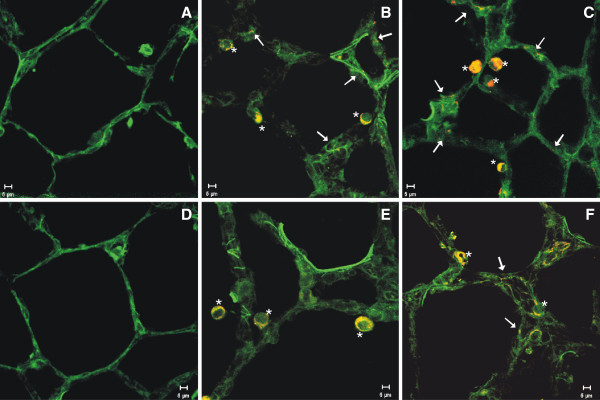
Confocal evaluation of tissue distribution of QD. Confocal micrographs of lungs (green) that have been cryo-preserved, sectioned, and imaged at 63x, 2 hours (A-C) and 1 day (D-F) after intratracheal instillation with 12.5 μg of QD-NH2, QD-COOH, or PBS (control): (A) control – 2 hours post-exposure, (B) QD-NH2 - 2 hours post-exposure, (C) QD-COOH – 2 hours post-exposure, (D) control – 1 day post-exposure, (E) QD-NH2 - 1 day post-exposure, and (F) QD-COOH – 1 day post-exposure. Lung tissue auto-fluoresces green and QD are yellow/red. * indicates QD-containing AM, white arrows indicate QD in tissue.